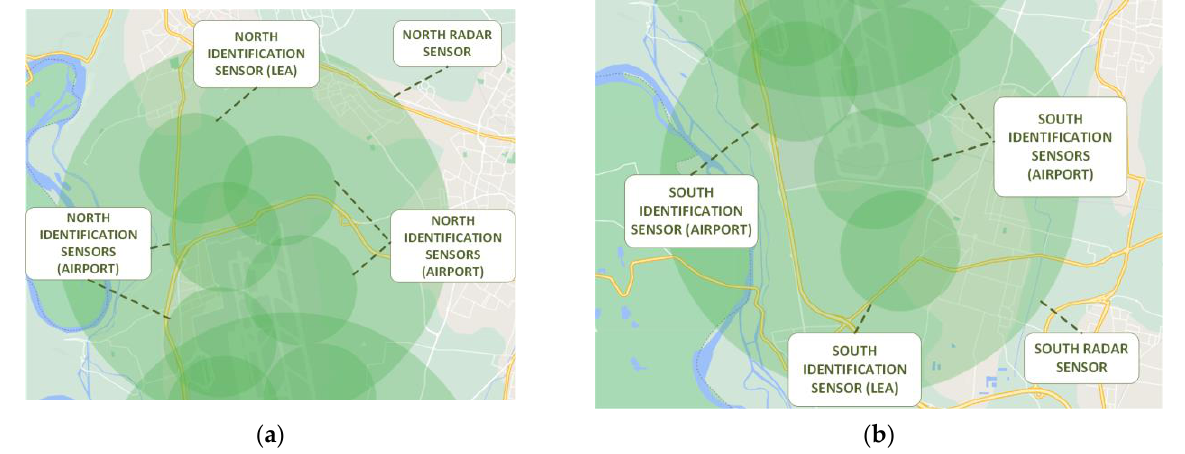
Figure 12. Displacement of counter-drone sensors for solution scenarios. ( a ) North part of LIMC. ( b ) South part of LIMC.